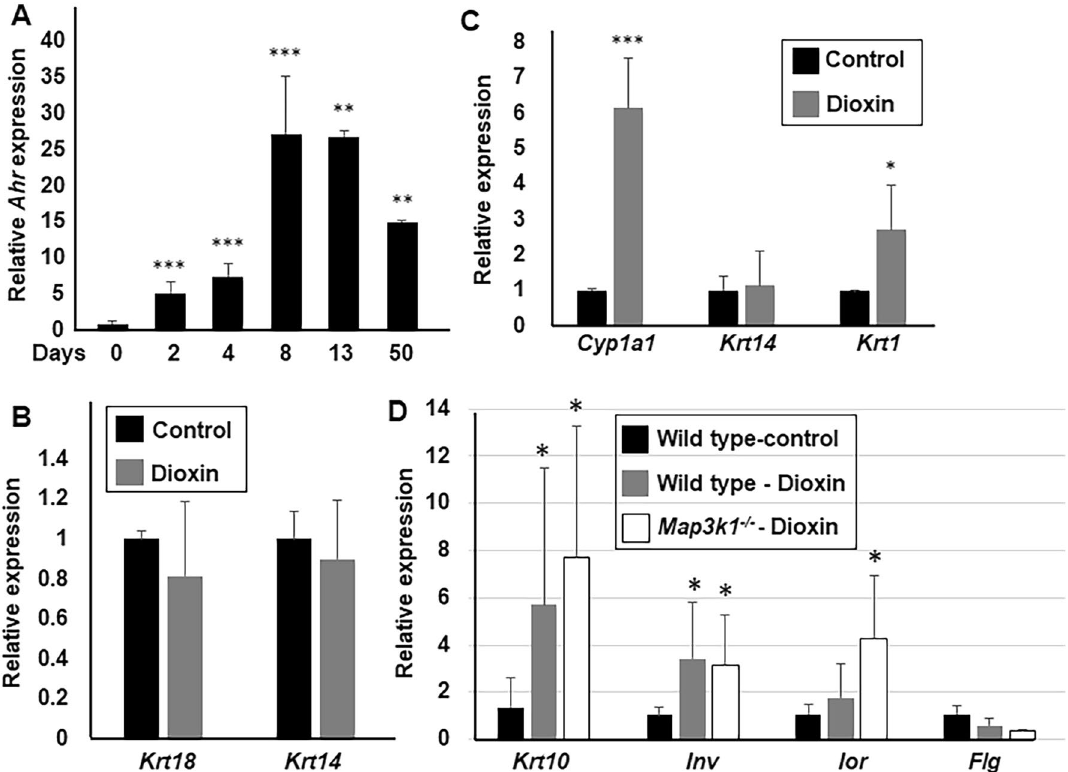
Figure 4. Dioxin potentiated suprabasal differentiation. Gene expression was examined using RT-PCR. ( A ) The Ahr expression was compared to levels in undifferentiated mESCs, set as 1. The expression of Krt 18 , Krt 14 , Krt 1, Krt 10, Inv, Lor, Flg and the AHR activation marker, Cyp1a1 were examined ( B ) in cells differentiated for 13 days and ( C and D ) in wild type and Map3k1 -/- D-KC, in the presence and absence of 10 nM dioxin as indicated. Statistical analyses and relative expression are based on comparison to ( A ) undifferentiated mESCs and ( B-D ) control wild type samples, set as 1. * p < 0.05, ** p < 0.01 and *** p < 0.001 are considered